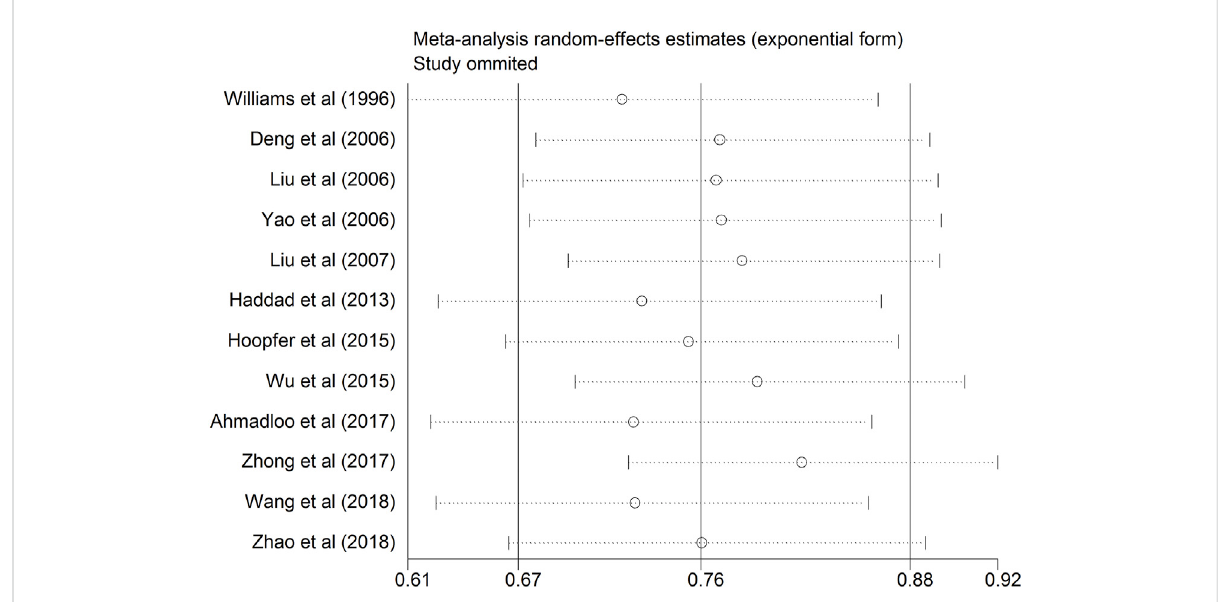
FIGURE 5 Sensitivity analysis after each study was excluded by turns with the STATA software.